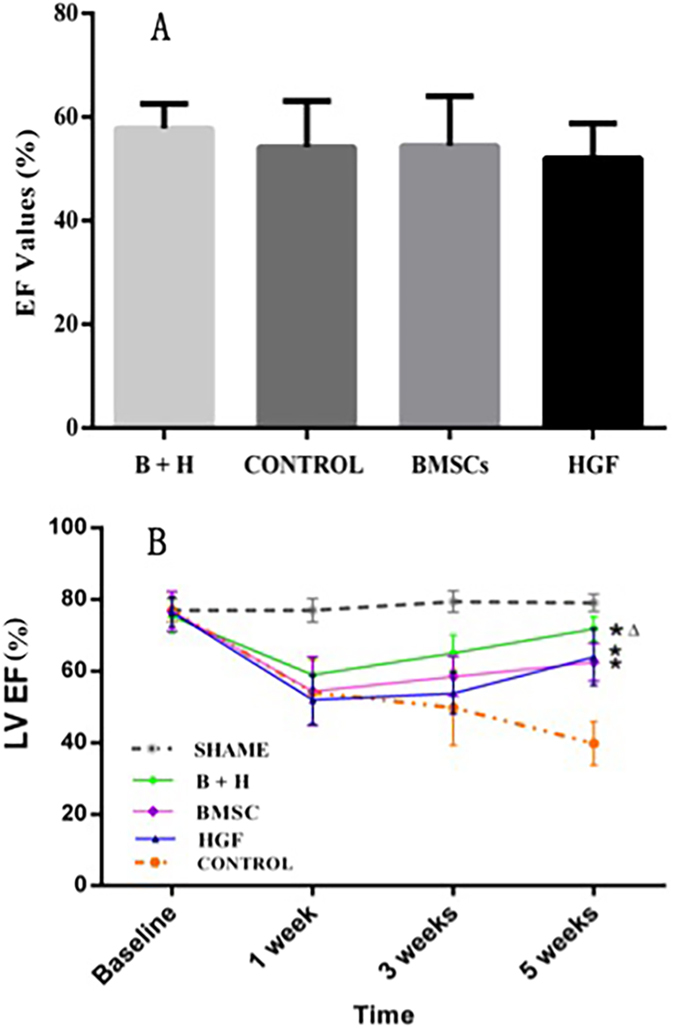
LV function after ligation was followed using cardiac MR imaging.(A) Baseline data showed no significant difference between pre-operation LVEF values among all the groups. (B) Before injection, no statistically significant differences in LVEF reductions were found among all treated groups and the control group (all p > 0.05) one week after MI. After injection, the LVEF of the control group continuously declined after ligation. LVEF was significantly increased in all treated groups (*p < 0.05 versus the control group), especially in the BMSCs/HGF treatment group (△p < 0.001).